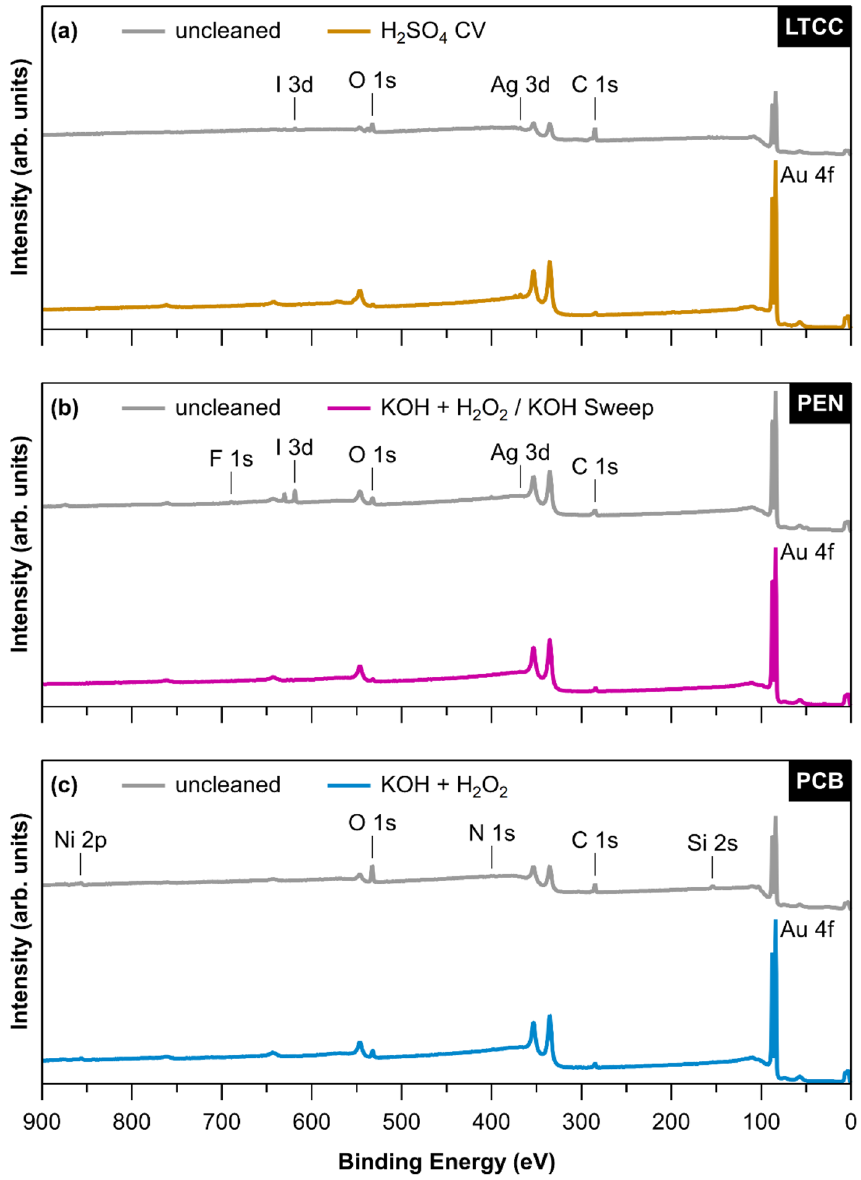
Figure 3. Representative XPS survey spectra of ( a ) LTCC, ( b ) PEN, and ( c ) PCB sensor surfaces. Spectra are shown for uncleaned samples and after the cleaning method deemed most efficient for each respective sample type and are offset for clarity. An increase in intensity of signals stemming from gold core level electrons can be observed, while contaminants such as carbon (C 1 s ) and oxygen (O 1 s ) are